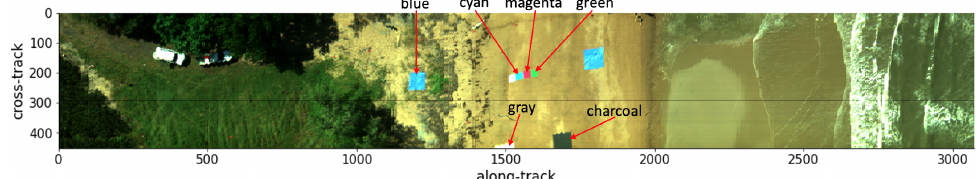
Figure 15. RGB visualisation of the digital numbers using the 640, 550, 470 nm bands. Colours are scaled to the 2–98% percentile and calibration tarps are